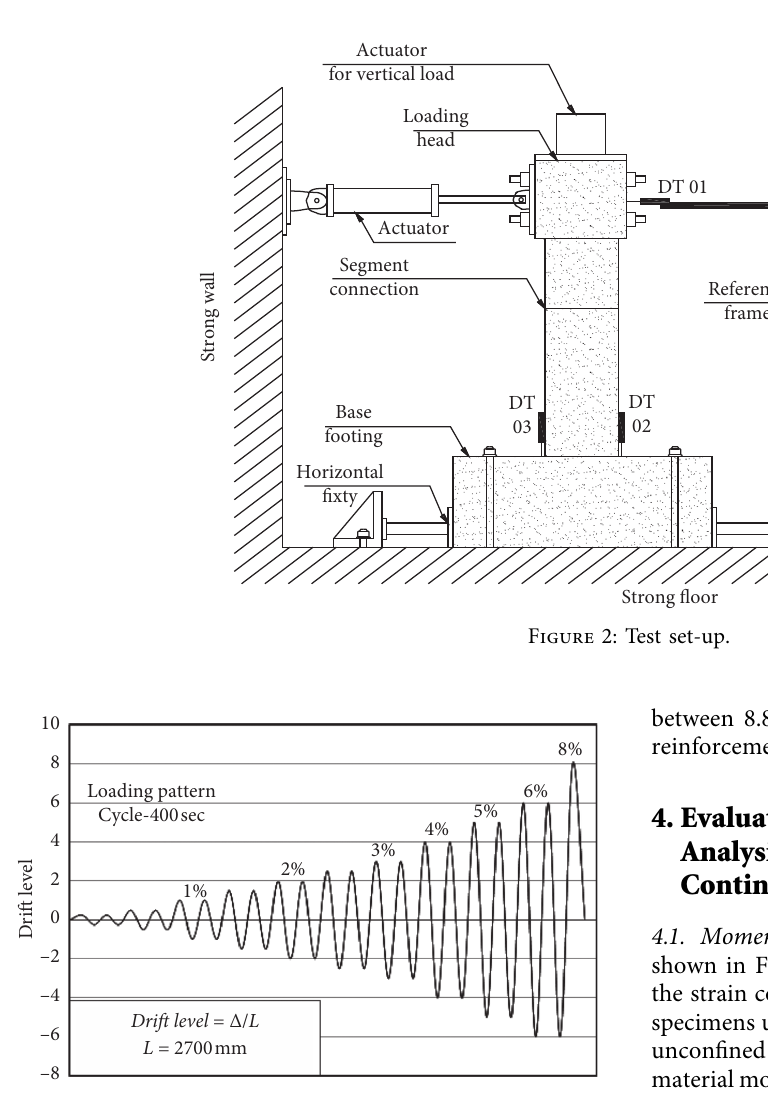
Figure 3: Loading